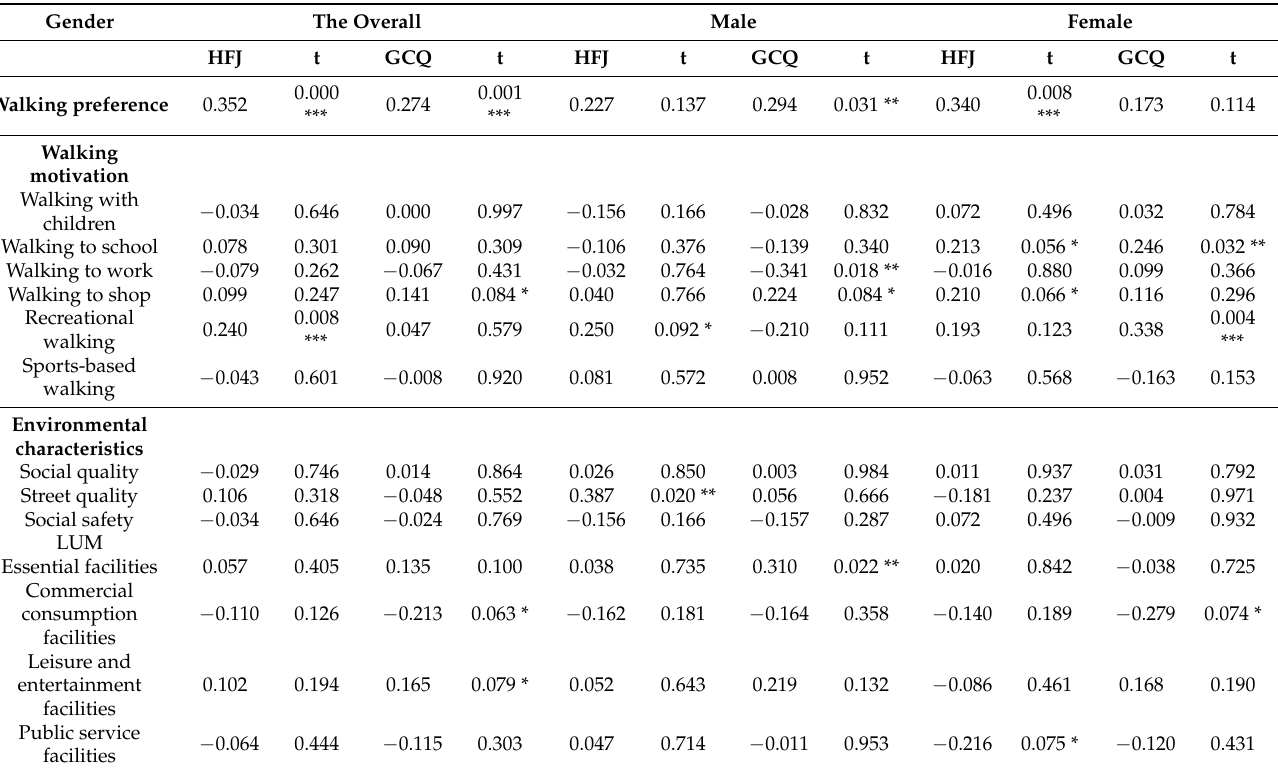
The data of pedestrian walking experience of both genders demonstrate that (Table 6): Table 6. Correlation analysis of daily walking time and multiple factors of pedestrians of different genders on two